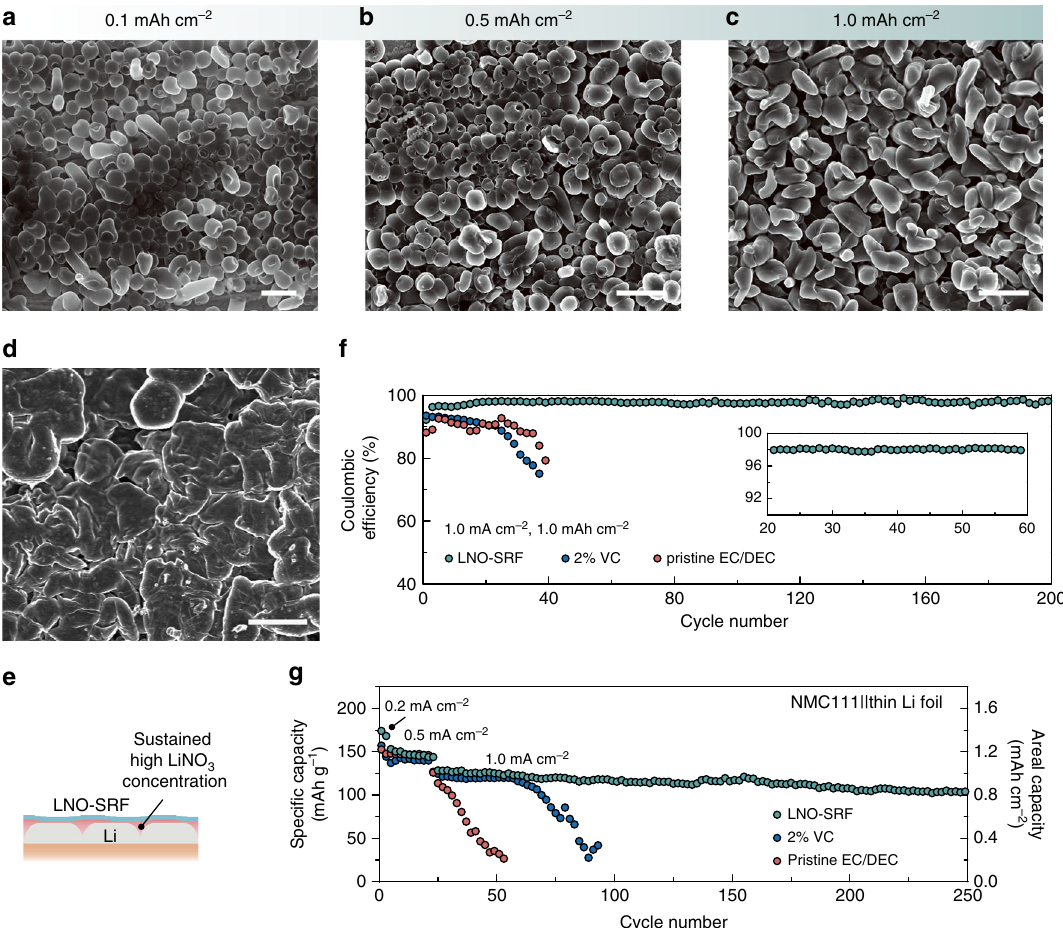
Fig. 3 Deposition morphology and cycling CE with LNO-SRF. SEM images of the Li deposition morphology on Cu substrate covered by LNO-SRF at a current density of 1 mA cm – 2 and a capacity of a 0.1 mAh cm – 2 , b 0.5 mAh cm – 2 , and c 1 mAh cm – 2 , respectively. d SEM image of the Li foil surface after 50 stripping/plating cycles in a Li||Li symmetric cell with LNO-SRF. The cycling was done at a current density of 1 mA cm – 2 and a capacity of 1 mAh cm – 2 . Scale bars, 2 μ m in a and 5 μ m in b – d . e The solubility-mediated dissolution of LiNO 3 from the microporous LNO-SRF can maintain a high local NO 3 – concentration at the anode surface during battery cycling, which therefore results in a sustained modulation of Li deposition morphology. f Li cycling CE at a current density of 1 mA cm – 2 and a capacity of 1 mAh cm – 2 on Cu without additives (pristine EC/DEC), and with VC (2% VC) or nitrate (LNO-SRF) as additive. The electrolyte used in all cases were 0.5 M LiPF 6 EC/DEC. g Long-term cycling performance of Li||NMC full-cell with a limited amount of excess Li (42 μ m thin Li foil) in 0.5 M LiPF 6 EC/DEC electrolyte (pristine EC/DEC) and in 0.5 M LiPF 6 EC/DEC electrolyte with VC (2% VC) or nitrate (LNO-SRF) as additive. The areal mass loading of NMC was ~8 mg cm – 2 . The fi rst two formation cycles were carried out at a current density of 0.2 mA cm – 2 , followed by 20 cycles at 0.5 mA cm – 2 , and the long-term cycling was at 1.0 mA cm –